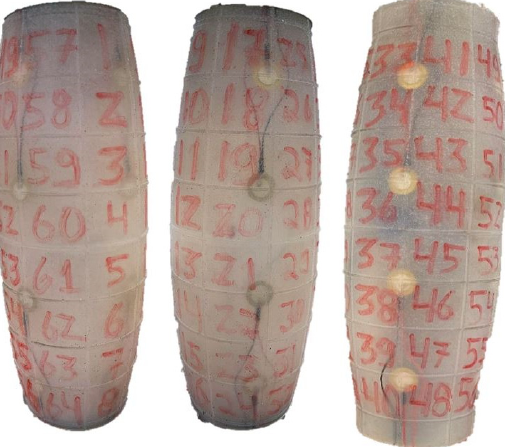
Figure 5. Test Sleeve with piezoelectric sensors (different angles of view).